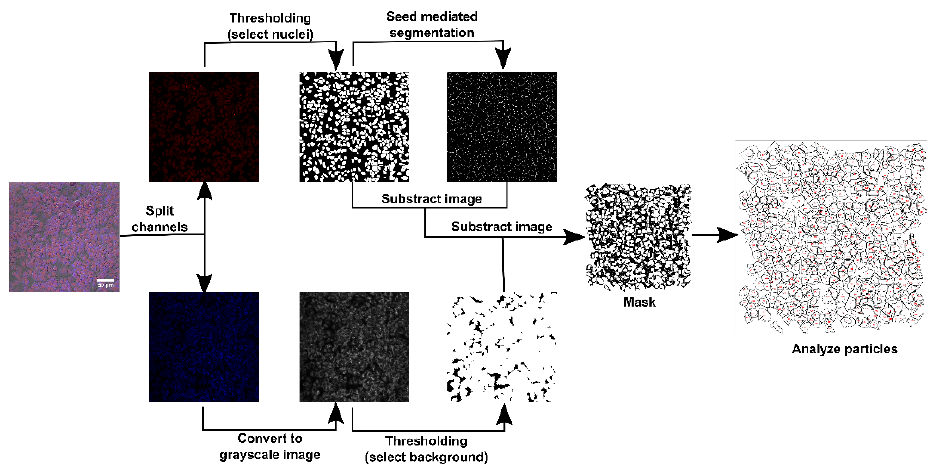
Figure 1. Pre-semiquantitative analysis image processing workflow.